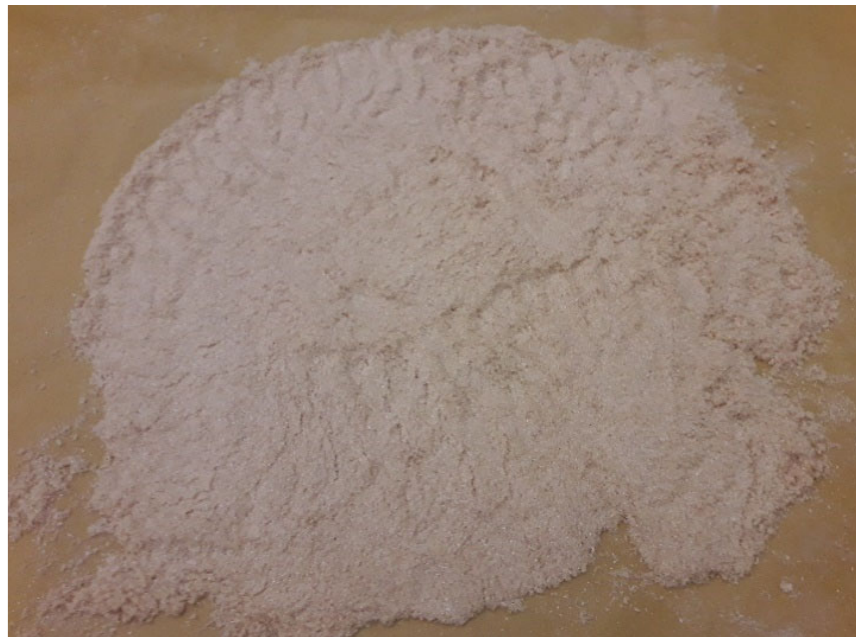
Figure 3. Thin layer of fibers sprayed with silane solution.